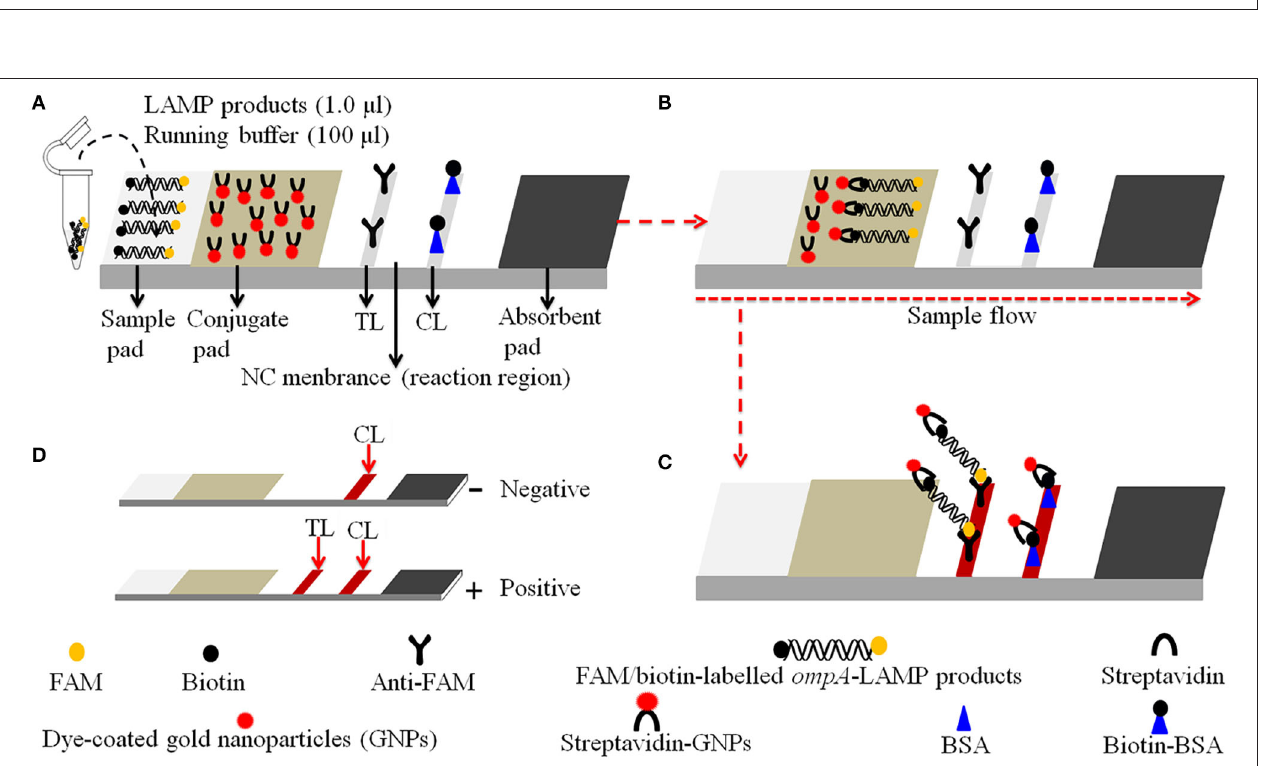
FIGURE 2 | Schematic diagram of the principle of LFB for visually readout C. trachomatis -LAMP products. (A) C. trachomatis -LAMP products and (1.0 µ l) and running buffer (100 µ l) were simultaneously added to the sample pad. (B) The running buffer and C. trachomatis -LAMP products move forward to conjugate pad and reaction region due to capillary action. (C) For positive results, the FAM/biotin-labeled ompA -LAMP products are arrested by anti-FAM at TL strip, and the streptavidin-DPNs are arrested through biotin-BSA at CL strip. For negative results, only the streptavidin-DPNs flow to reaction region and arrested by biotin-BSA at CL strip. (D) Interpretation of the C. trachomatis -LAMP-LFB assay results: negative—only the CL appears on the LFB; positive—CL and TL appear on biosensor.